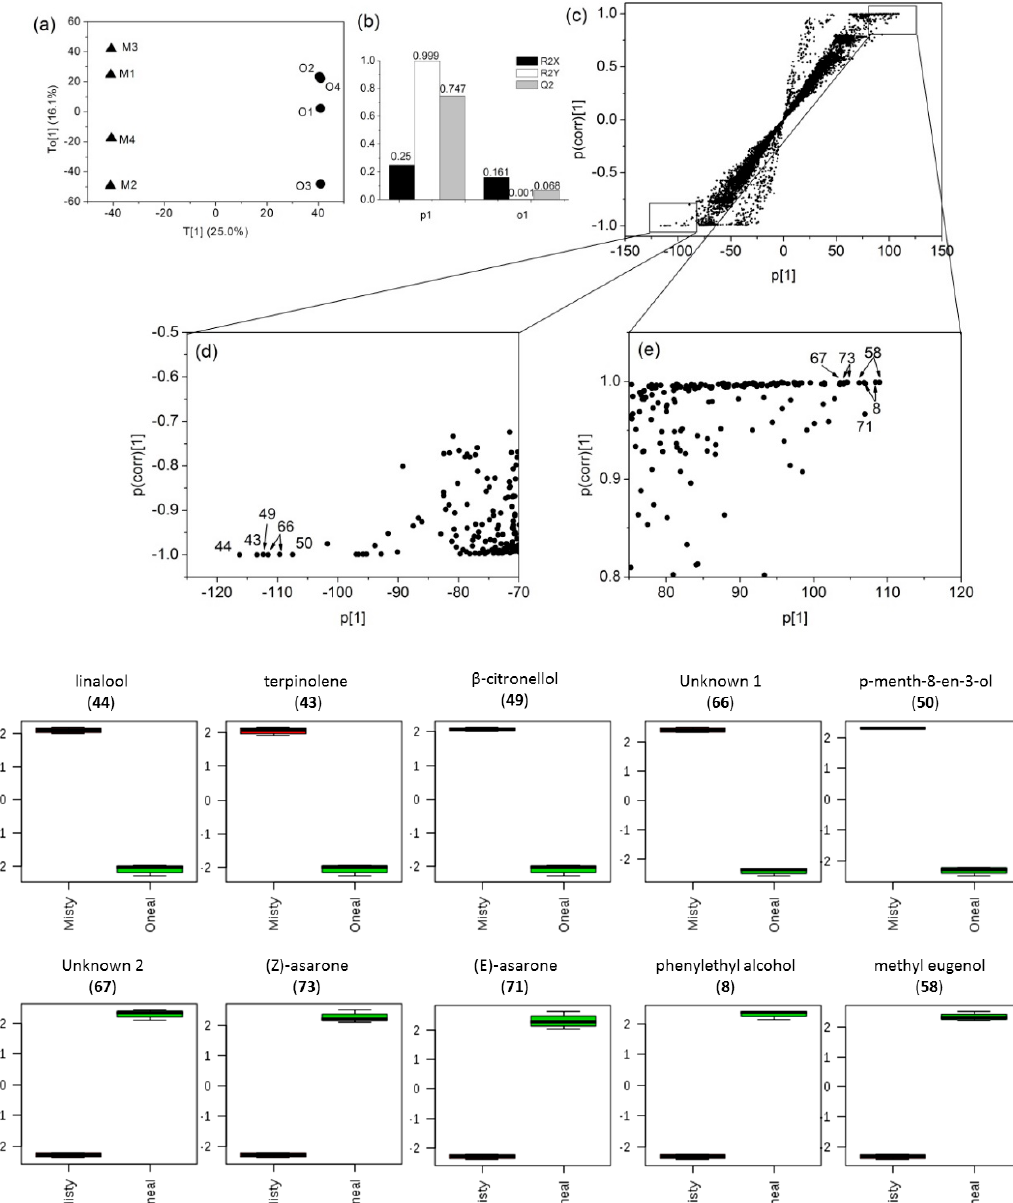
Figure 4. OPLS-DA of metabolite features detected in the blueberry wines by SPME-GC-QTOF-MS. ( a ) Score plot of all metabolite features; ( b ) Model overview of the OPLS-DA model; ( c – e ) Loadings S-plot showing the variable importance in a model, combining the covariance and the correlation (p(corr)) loading profile. The box-plots at bottom showed the significantly different volatile metabolites between Misty blueberry wine (M1, M2, M3, M4) and O’Neal blueberry wine (O1, O2, O3, O4) in the OPLS-DA model (Line, mean; box, standard error; whisker, standard deviation).